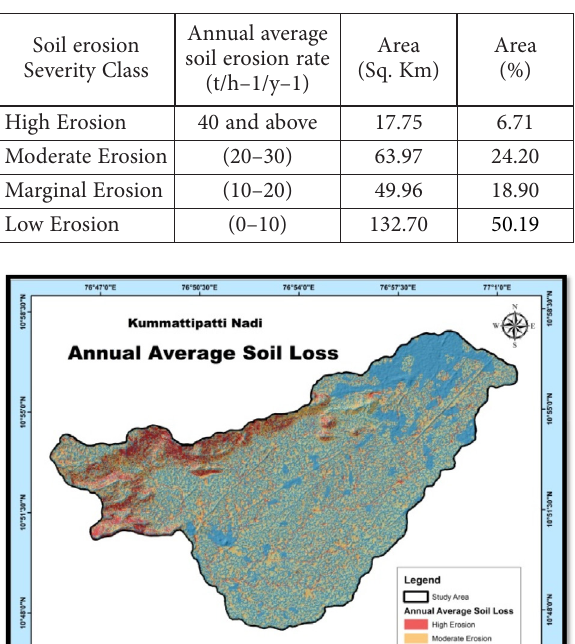
Table 3. Soil erosion severity classes with average